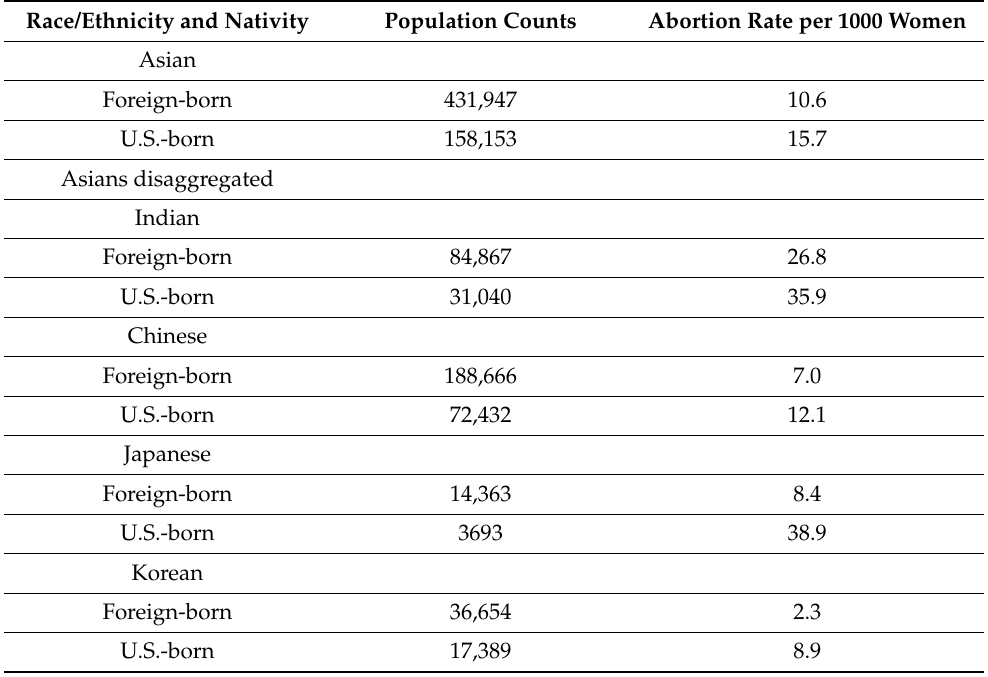
Table 2. Age-standardized abortion rates among Asian populations in New York City by nativity status,